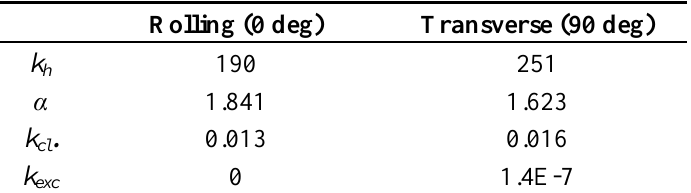
Table 1. Iron loss parameters.